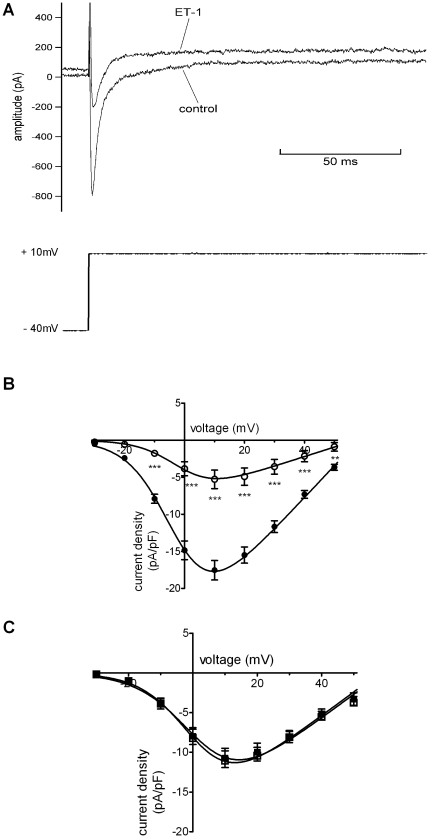
Effects of ET-1 on the L-type Ca2+ current (ICa,L).A. Representative records of ICa,L (upper traces) elicited at +10 mV from a holding potential of −40 mV by protocol shown in lower traces, in both the absence (control) and presence of 10 nM ET-1. B. Plots of the mean I–V relations for ICa,L (n = 11), measured as peak - end pulse difference current, in control (filled circles) and with ET-1 (open circles): I–V curves were fitted using equation 1 (Methods) to give V0.5 values of −2.7±0.6 mV in control and −1.0±1.9 mV in ET-1 (p>0.1). Corresponding k values were 7.1±0.5 mV and 6.5±1.7 mV in control and ET-1, respectively (p>0.7). C. I–V relations (n = 12) for ICa,L in the presence of 1 µM BQ-123 (filled squares) and when 10 nM ET-1 was applied in the maintained presence of BQ-123 (open squares). V0.5 values were 2.1±1.1 mV and 1.0±1.0 mV respectively for BQ-123 and BQ-123+ET-1 (p>0.4), with corresponding k values of 8.2±0.9 mV and 7.4±0.9 mV (p>0.5). Asterisks in ‘B’ denote statistical significance (p<0.01 **, p<0.001 ***).